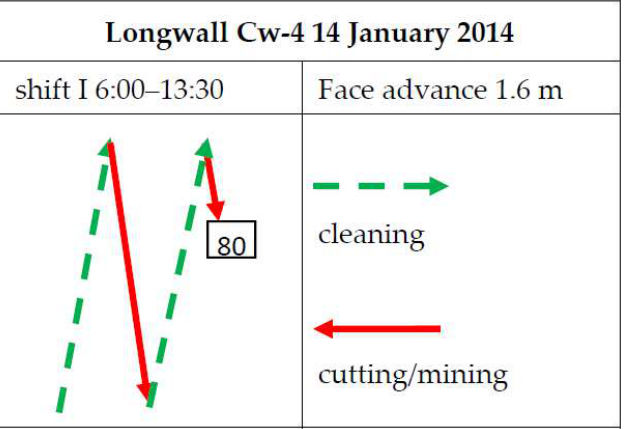
Figure 2. Shearer operations in longwall Cw-4 recorded by operation controller. 3.1. Recording of the Air Velocity by the Monitoring System in the Longwall Cw-4 Area The air velocity in the longwall Cw-4 area was recorded by the monitoring system (Figure 1). This comprised of three anemometers and two anemometers at the intake/inlet V369 and outlet V2349 outside the area, respectively. The recorded air velocities revealed significant fluctuations in the instantaneous values. Only after the application of signal smoothing using the moving average method were the air velocity curves made legible (Figure 3). Figure 3 provides the registered air velocities in the analyzed period (i.e., from 7:40 to 9:20).